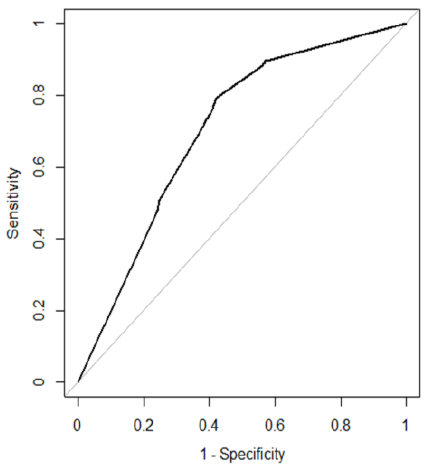
Figure 6. ROC curve for DNN (Tanh w/Dropout). (AUC = 0.600, F-score = 0.620).